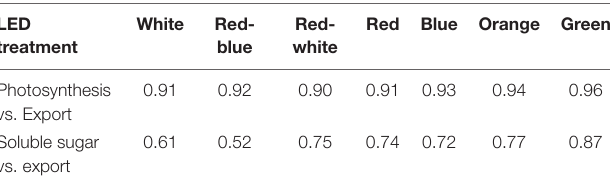
(Supplementary Table 1). Blue light activates